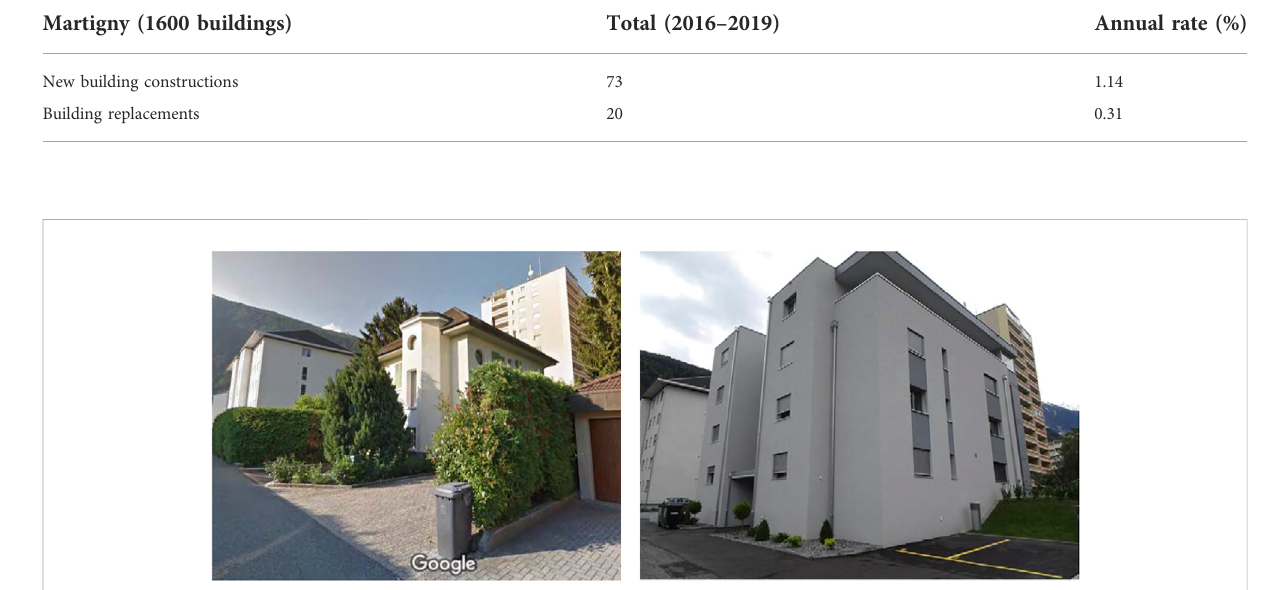
FIGURE 10 Martigny, low-rise URM building demolished and replaced by a mid-rise RC building.